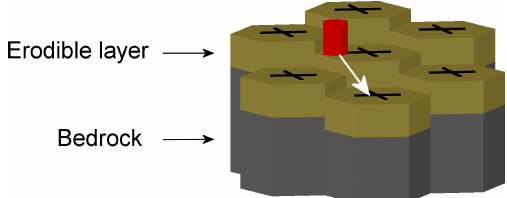
Figure 4. Outflow direction from central cell to the center of an adjacent cell in three